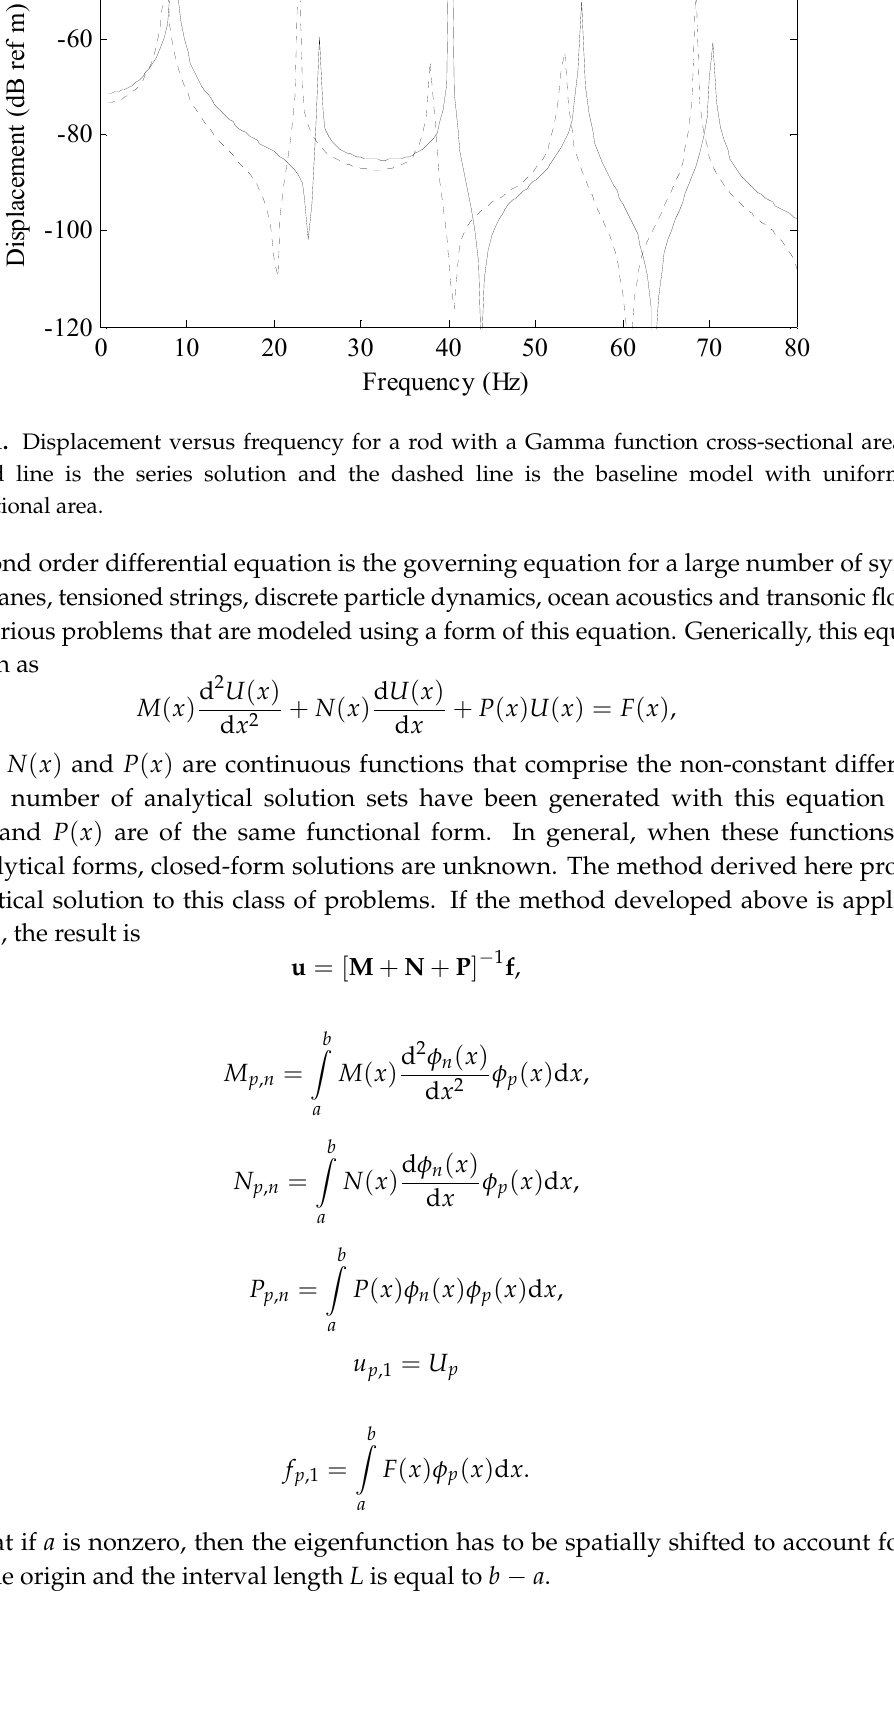
Figure 10. Fixed-free rod with a Gamma function change of area.